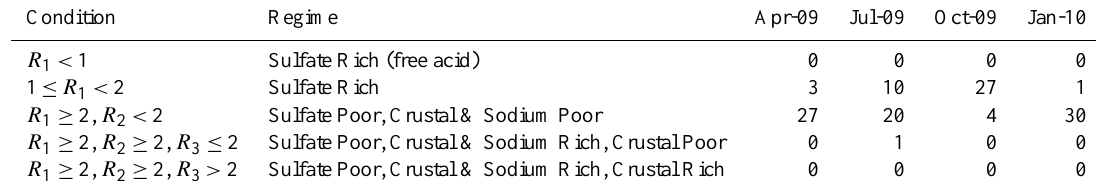
Table 3. Quantities of PM 2 . 5 samples which were categorised to the five chemical composition regimes. Condition Regime Apr-09 Jul-09 Oct-09 Jan-10 R 1 < 1 Sulfate Rich (free acid) 0 0 0 0 1 ≤ R 1 < 2 Sulfate Rich 3 10 27 1 R 1 ≥ 2, R 2 < 2 Sulfate Poor, Crustal & Sodium Poor 27 20 4 30 R 1 ≥ 2, R 2 ≥ 2, R 3 ≤ 2 Sulfate Poor, Crustal & Sodium Rich, Crustal Poor 0 1 0 0 R 1 ≥ 2, R 2 ≥ 2, R 3 > 2 Sulfate Poor, Crustal & Sodium Rich, Crustal Rich 0 0 0 0